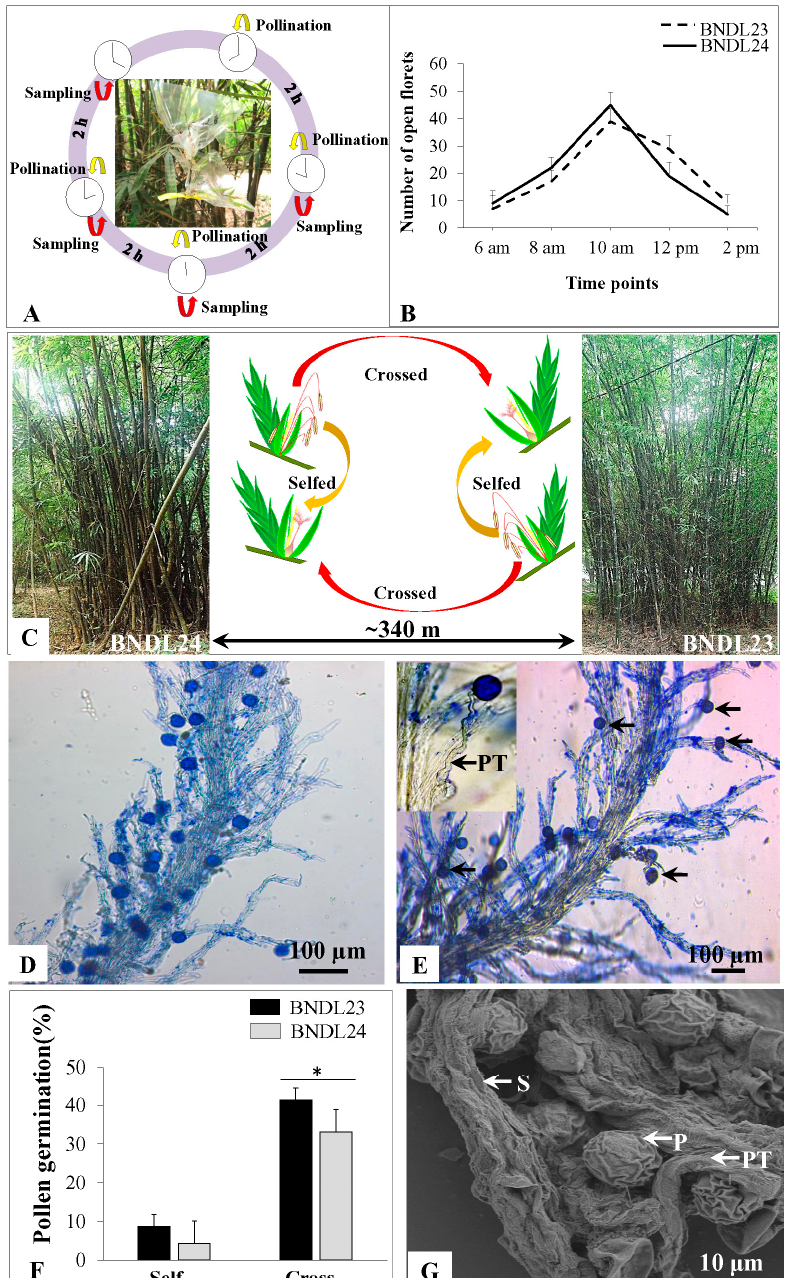
Figure 7. Experimental design and microscopic observation to study in vivo pollen-pistil interaction in B. tulda . ( A ) Time course experiment was conducted to identify the optimum time point for pollination. ( B ) Line graph demonstrating the optimum time point for opening of the B. tulda flower. ( C ) Schematic representation of the experimental set up. ( D ) Magnified view of stained stigma after self pollination. Pollen tubes are marked by an arrow. ( E ) Magnified view of stained stigma after cross pollination. Pollen tubes are marked by an arrow. ( F ) Histogram demonstrating the relative abundance of self vs. crossed pollination in two populations of B. tulda . Two-sample approximate z- test was performed to test statistical significance at p < 0.000. While performing the test of significance, data for cross pollination obtained from BNDL23 and BNDL24 were pooled and compared to the pooled data obtained for self pollination. ( G ) Scanning electron microscopic (SEM) image of stigma after cross pollination. Abbreviations used: h—Hour, S—Stigma, PT—Pollen tube,